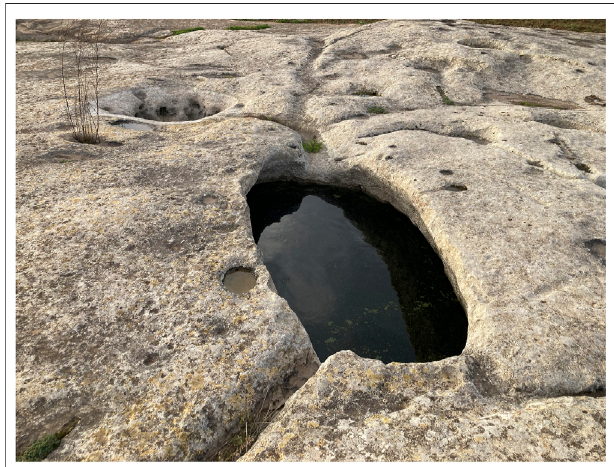
FIGURE 12 | Some of the channels and deep cisterns of the “ Misqa Tanks. ” Located close to Mnajdra and Ħ a ġ ar Qim temples, they have been suggested to possibly represent Temple Period water